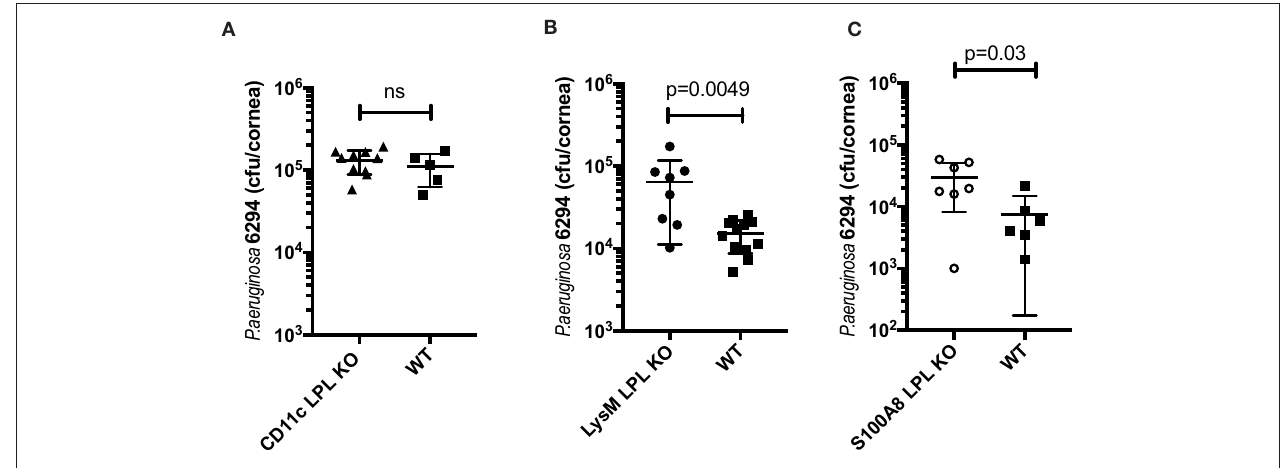
FIGURE 4 | The susceptibility to infection segregated with LysM-driven and S100A8-driven ablation of L-plastin, but not with CD11c-driven ablation. (A) LPL deficiency in the CD11c + DCs does not contribute to the phenotype. LPL floxed mice were crossed onto CD11c.Cre pos to generate L-plastin deficiency in the CD11c-expressing cells. CD11c.Cre pos LPL fl / fl mice did not show altered susceptibility to P. aeruginosa 6294-induced infection as demonstrated by similar corneal bacterial burden at 24h post-challenge. Data are from experiments performed in duplicates with each data point representing an individual animal (Student’s t- test, ns). (B) LPL deficiency in the macrophage/neutrophil lineages contributes to susceptibility to disease. LPL floxed mice were crossed onto LysM.Cre pos background to generate L-plastin deficiency in the myeloid/neutrophil lineage. Student’s t -test, p = 0.0049. (C) LPL deficiency in the neutrophil lineage contributes to susceptibility to disease. LPL floxed mice were crossed onto S100A8.Cre pos background to generate L-plastin deficiency in the neutrophil lineage. Student’s t -test, p = 0.03. Data prove that L-plastin deficiency in the myeloid compartment determines susceptibility to keratitis.